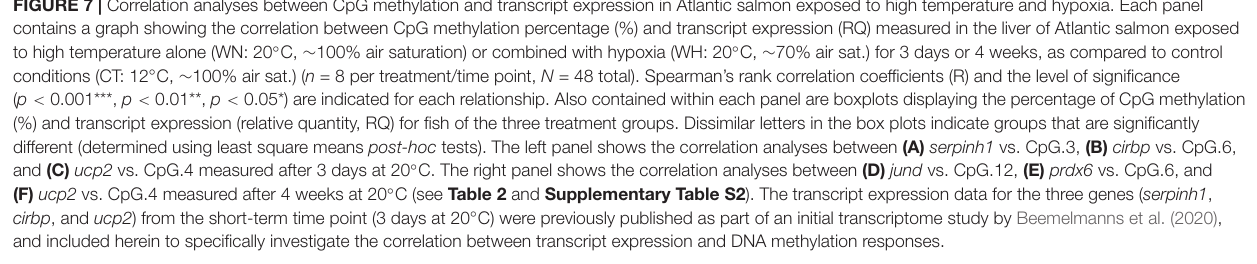
FIGURE 7 | Correlation analyses between CpG methylation and transcript expression in Atlantic salmon exposed to high temperature and hypoxia. Each panel contains a graph showing the correlation between CpG methylation percentage (%) and transcript expression (RQ) measured in the liver of Atlantic salmon exposed to high temperature alone (WN: 20 ◦ C, ∼ 100% air saturation) or combined with hypoxia (WH: 20 ◦ C, ∼ 70% air sat.) for 3 days or 4 weeks, as compared to control conditions (CT: 12 ◦ C, ∼ 100% air sat.) ( n = 8 per treatment/time point, N = 48 total). Spearman’s rank correlation coefficients (R) and the level of significance ( p < 0.001***, p < 0.01**, p < 0.05*) are indicated for each relationship. Also contained within each panel are boxplots displaying the percentage of CpG methylation (%) and transcript expression (relative quantity, RQ) for fish of the three treatment groups. Dissimilar letters in the box plots indicate groups that are significantly different (determined using least square means post-hoc tests). The left panel shows the correlation analyses between (A) serpinh1 vs. CpG.3, (B) cirbp vs. CpG.6, and (C) ucp2 vs. CpG.4 measured after 3 days at 20 ◦ C. The right panel shows the correlation analyses between (D) jund vs. CpG.12, (E) prdx6 vs. CpG.6, and (F) ucp2 vs. CpG.4 measured after 4 weeks at 20 ◦ C (see Table 2 and Supplementary Table S2 ). The transcript expression data for the three genes ( serpinh1 , cirbp , and ucp2 ) from the short-term time point (3 days at 20 ◦ C) were previously published as part of an initial transcriptome study by Beemelmanns et al. (2020), and included herein to specifically investigate the correlation between transcript expression and DNA methylation